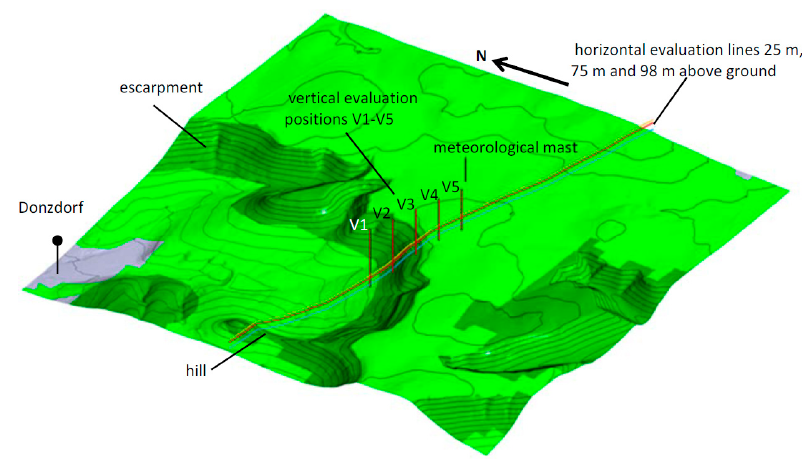
Figure 3. Nested domain 4 × 4 with vertical evaluation lines V1–V5 and horizontal evaluation lines 25 m (blue), 75 m (red), and 98 m (orange) above ground, as well as met mast position.